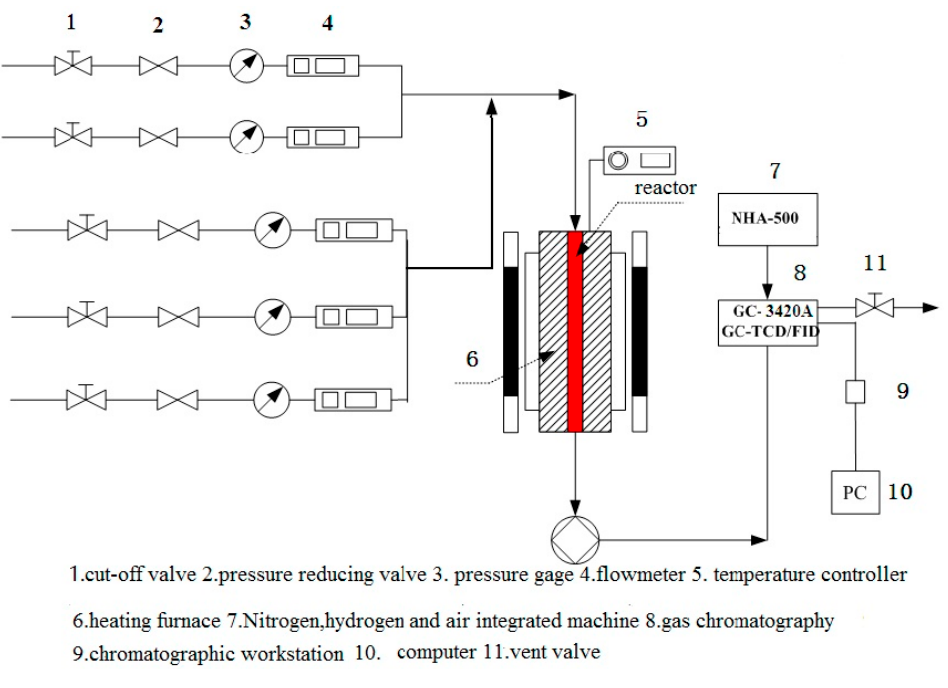
Figure 1. Schematic of the experimental set ‐ up.